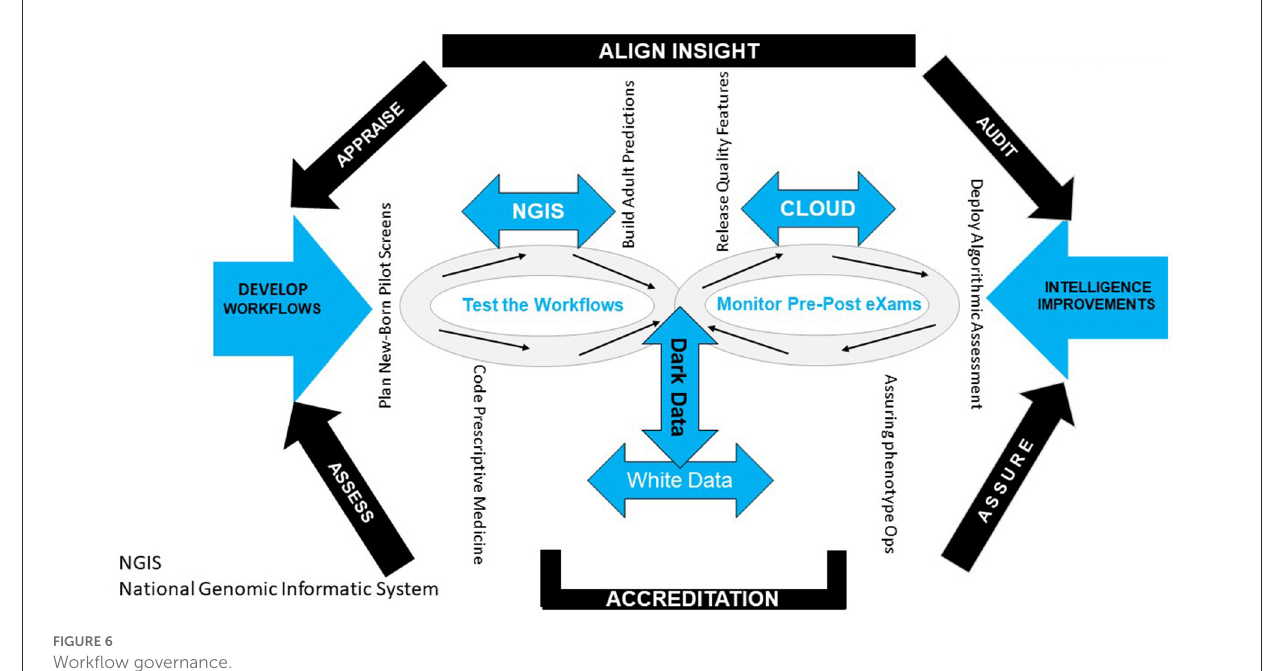
FIGURE6 Workflow